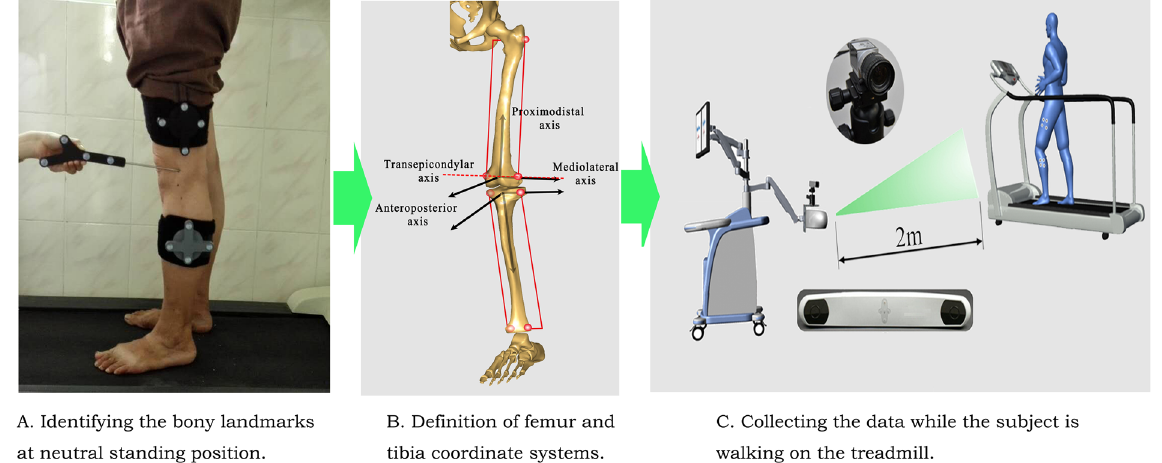
Figure 4. The process of gait analysis. ( A ) The doctor is holding the hand-held digitizing probe to identify the nine bony landmarks (greater trochanter, lateral epicondyle, medial epicondyle, lateral plateau, medial plateau, tibial tuberosity, fibular head, medial malleolus, and lateral malleolus). ( B ) According to the nine bony landmarks, the system sets up the 3D position of tibia and femur. ( C ) The gait system is collecting trajectories of femur relative to tibia while the subjects are walking in the